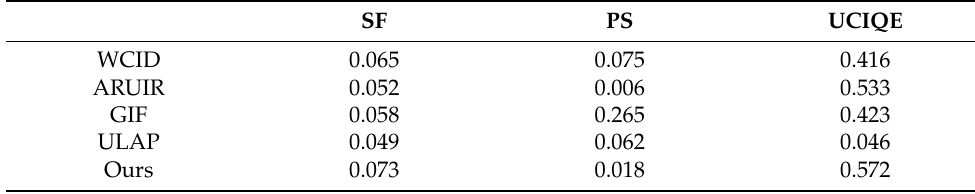
Table 1. Quantitative analysis of Figure 5.